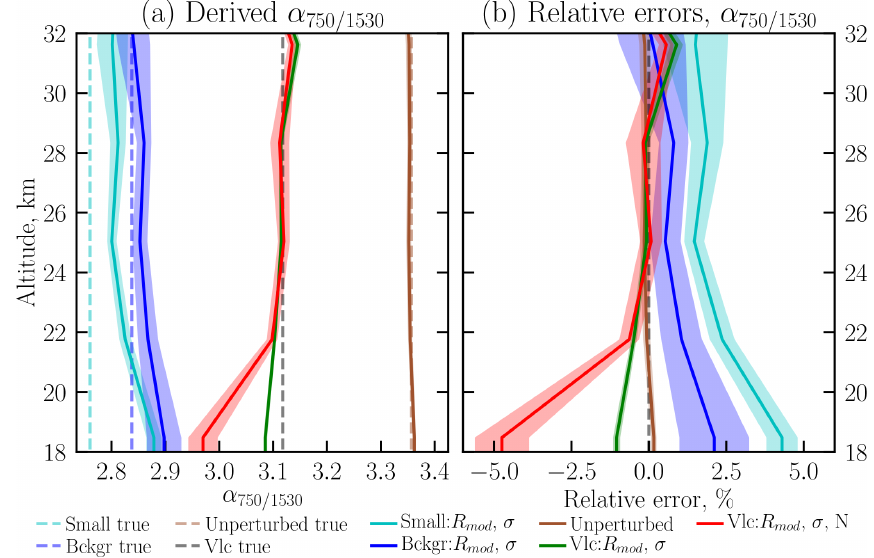
Figure 4. Ångström exponent profiles ( α 750 / 1530 ) (a) and their relative parameter errors (b) for a typical tropical observation geometry. The solid lines show the profiles derived from the PSD product, while the dashed lines represent the true values. The shaded areas stand for ± 1 standard deviation. The scenarios used for the simulations are listed in Table